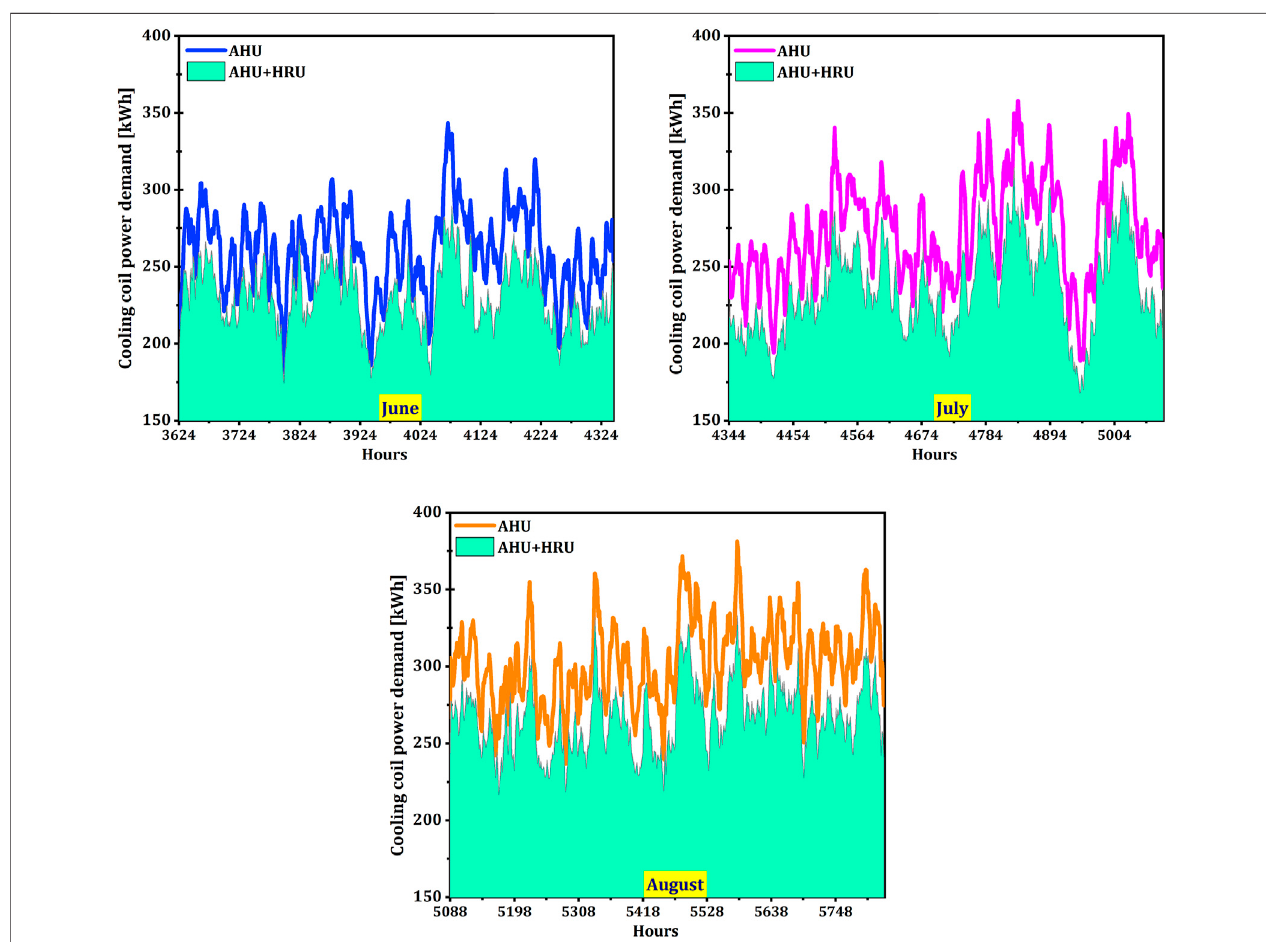
FIGURE 7 | PC CC comparison between AHU and AHU +